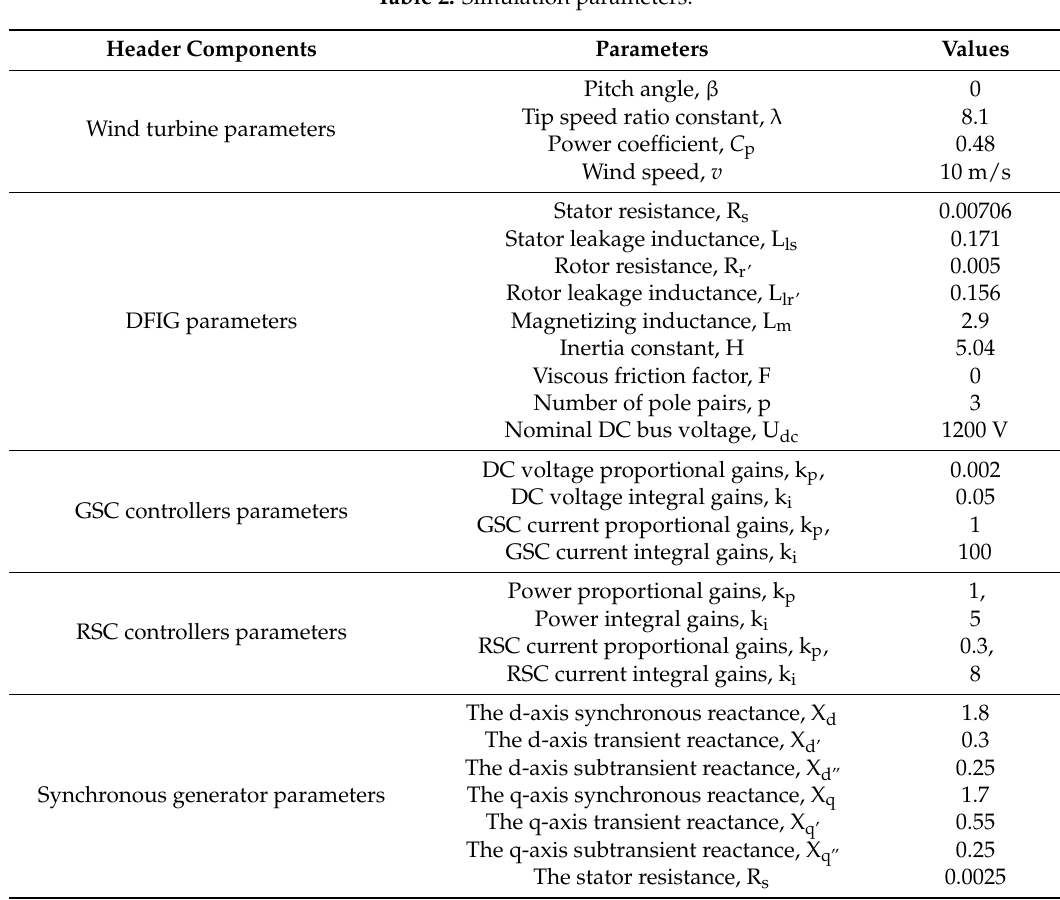
Table 2. Simulation